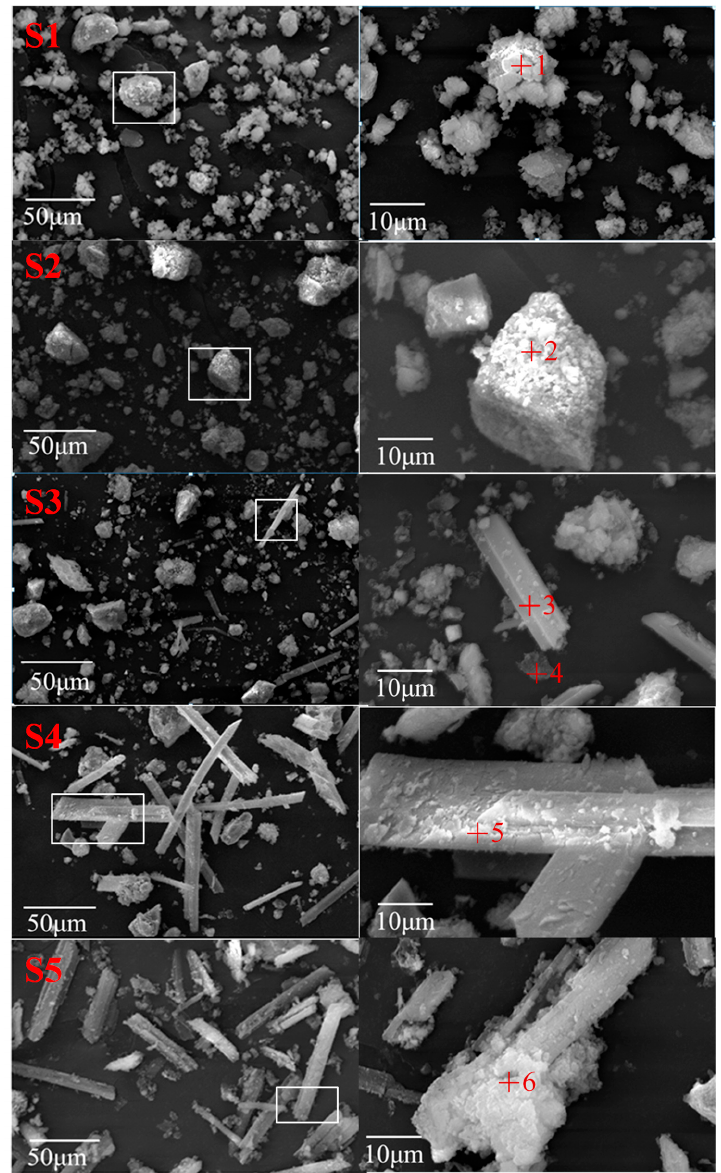
Figure 6. SEM images of steel slags titrated with simulated AMD. Table 3. The elemental compositions of the slags via